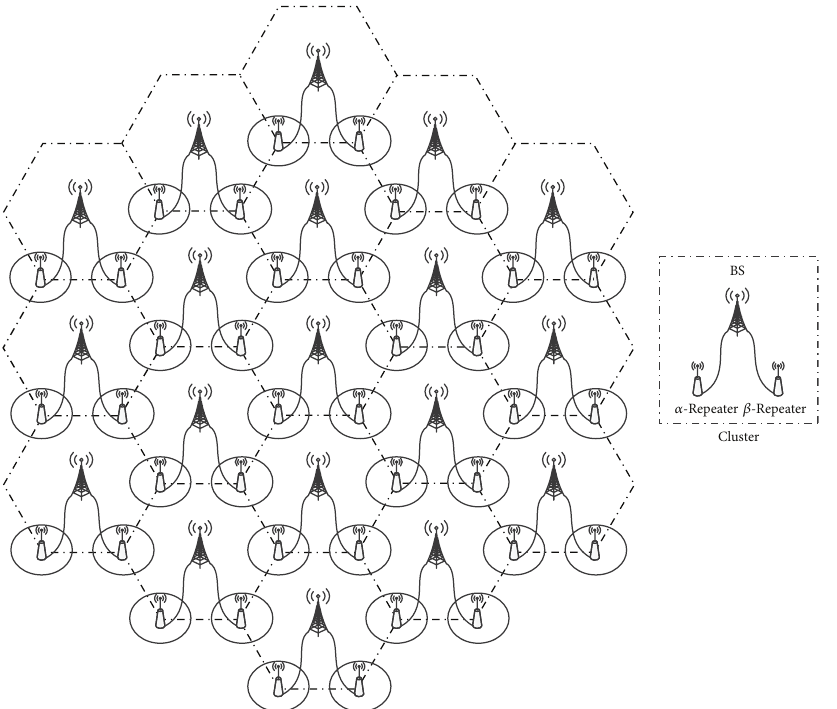
Figure 3: Cell layout for performance evaluation. The concept of 𝛼 and 𝛽 repeaters is used only in the proposed scheme. In other repeater networks, a single type of repeater is connected to the BS.